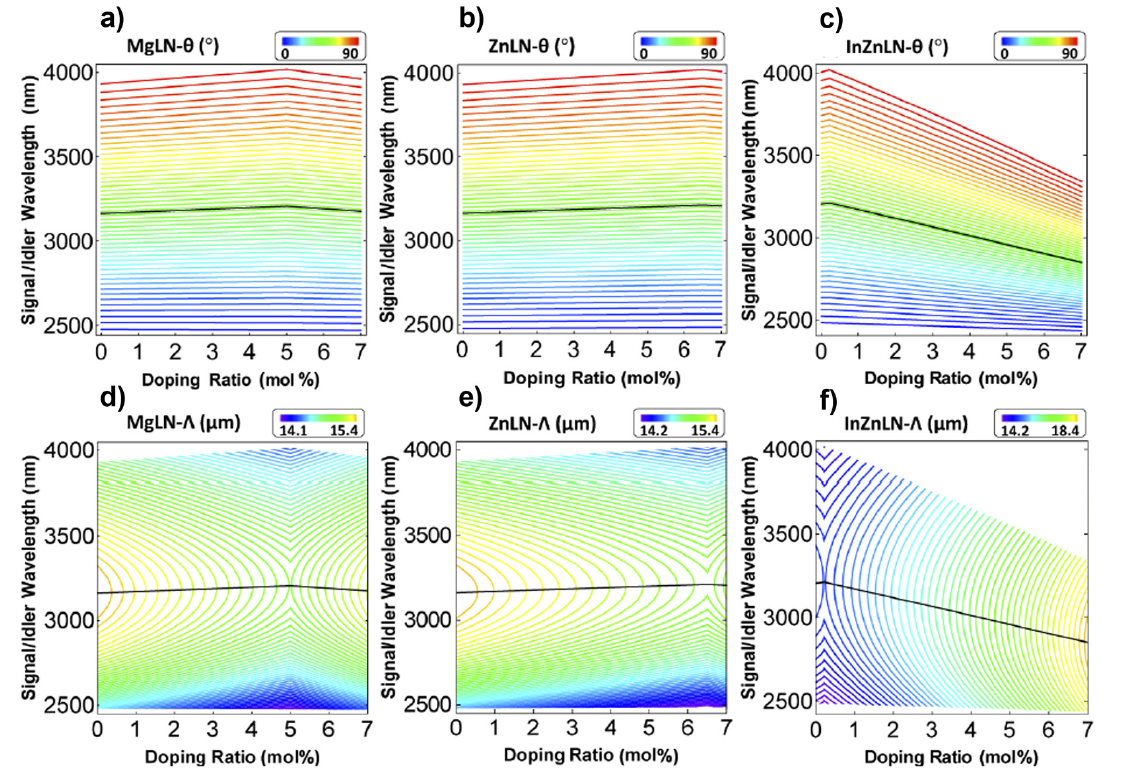
Figure 7. ( a – c ) The signal (idler) wavelength as a function of the doping ratio for MgLN, ZnLN and InZNLN for different tilt angles, with the corresponding poling period ( d – f ). The simulated process is type-II SPDC with degenerate signal and idler photons. The configuration corresponding to θ = 45° is indicated with solid black lines. Reproduced with permission from [57], copyright 2021.